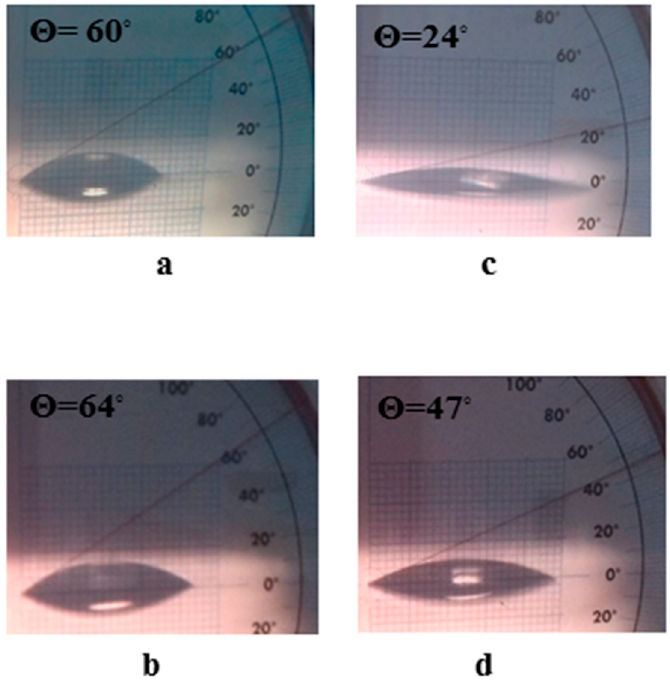
Figure 5. Optical images for water contact angle ( θ ) to glass surfaces that were uncoated ( a ) or coated by quercetin (Q) ( b ), titanium dioxide-decorated multi-walled carbon nanotubes (MWCNTs/TiO 2 ) ( c ) quercetin quercetin titanium dioxide-decorated multi-walled carbon nanotubes nanocomposite (Q/MWCNTs/TiO 2 ) ( d ).